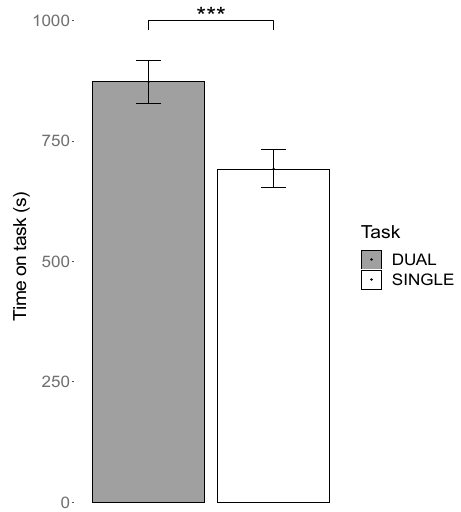
Figure 5. Mean time on task (s) as a function of task difficulty. *** p < 0.001.